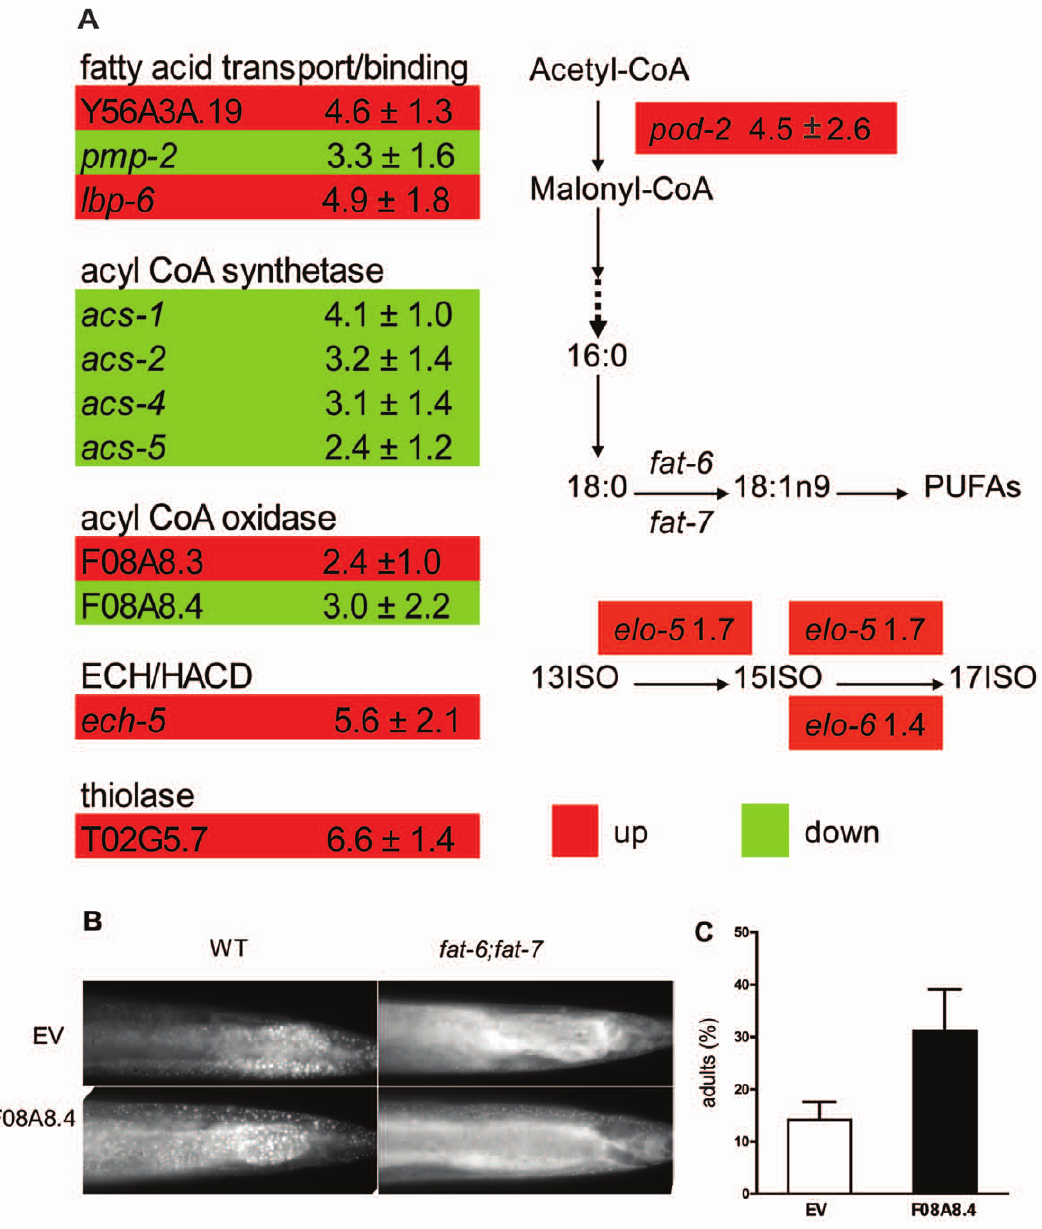
Figure 5. NHR-64 affects transcription of metabolic genes. (A) Quantitative RT-PCR was use to investigate the expression of 89 metabolic genes in L4 stage nematodes treated with nhr-64RNAi compared to empty vector controls. Worms were grown on E. coli strain HT115. For full list of genes tested, see Table S1. Data shown are the average of three or four biological determinations. (B) Fat staining of fixed wild-type and fat-6;fat-7 young adults treated with RNAi corresponding to F08A8.4 shows that depletion of the acyl-CoA oxidase encoded by F08A8.4 leads to increased fat stores. Anterior is left and posterior is right. (C) Inactivation of F08A8.4 in fat-6;fat-7 double mutants resulted in increased growth rate. The number of worms that had reached adult stage in a population were counted 72 hours after plating synchronized L1 stage larvae. The experiment was repeated three times, each time with 100–200 worms. Error bars are SEM.